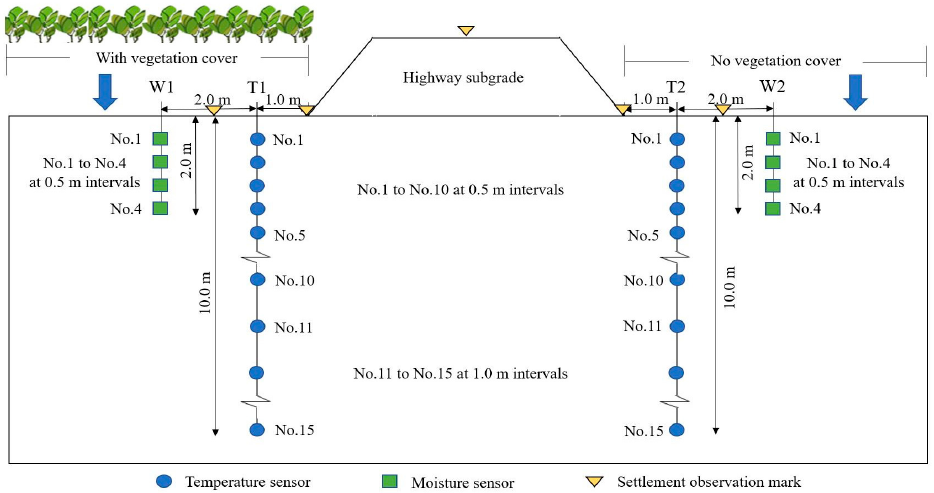
Figure 4. The layout of observation sensors in the K67+300 subgrade